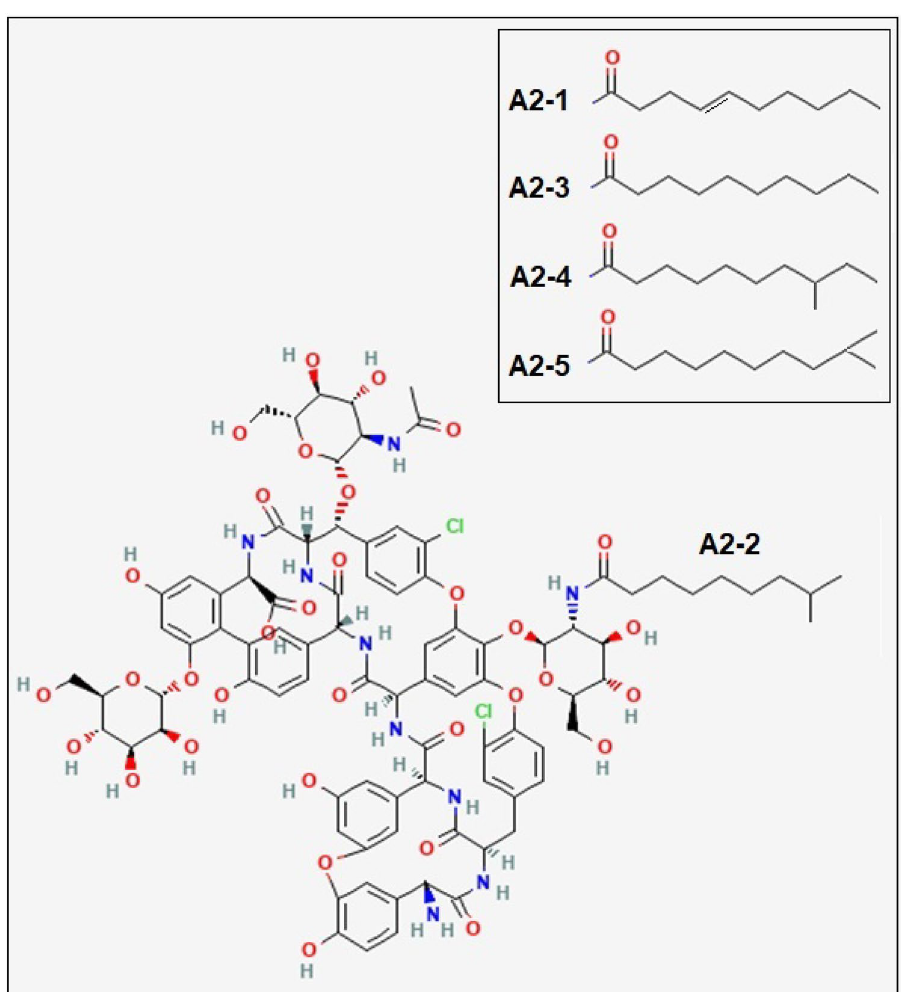
Figure 1. Structure of teicoplanin (adapted from the National Institute for Health/ National Center of Biotechnology Information 36 based on an original structure given by F. Parenti 37